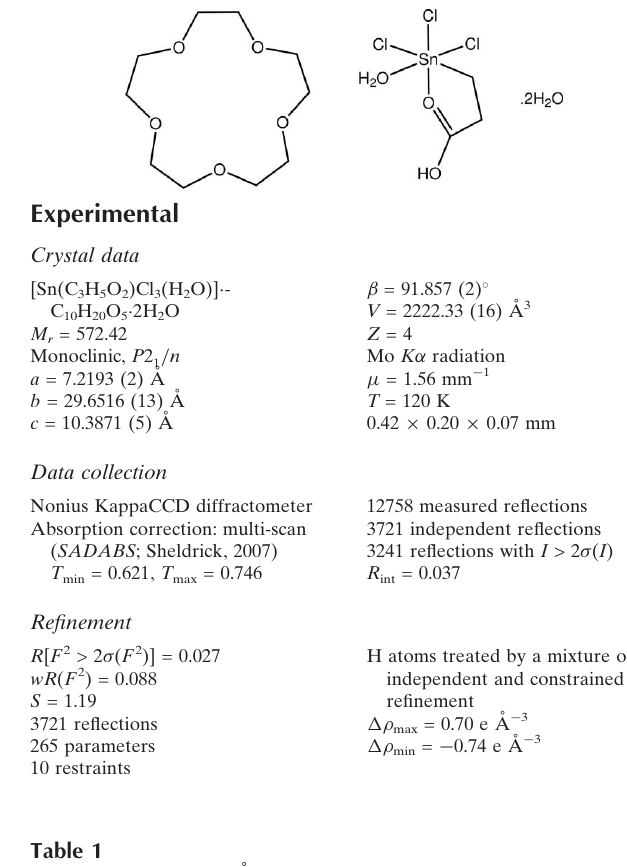
Selected bond lengths (A˚ ).